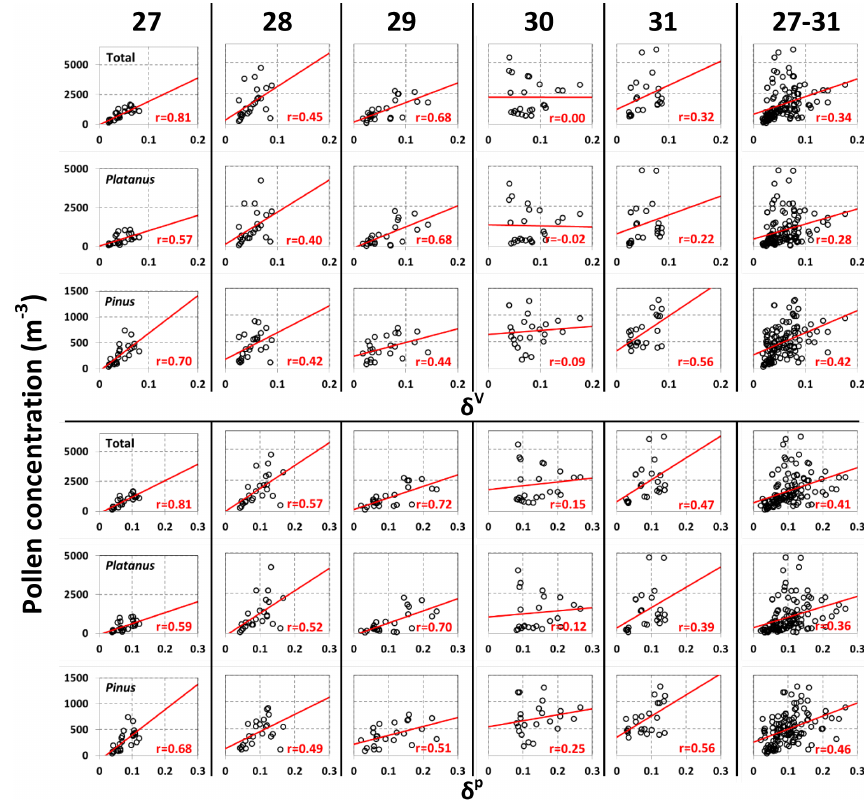
Figure 6. Scatter plot of the pollen concentration (total, Platanus and Pinus ) vs. the volume ( δ V ) and the particle ( δ p ) depolarization ratio integrated in the pollen plume for all 5 days of the pollination event. The linear regression line is in red and the correlation coefficient, r , is reported.